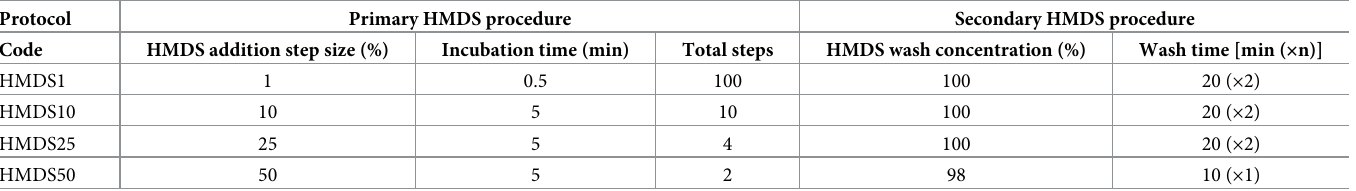
Table 1. The hexamethyldisilazane (HMDS) drying protocols tested. The procedures were all carried out at room temperature (~23˚C), and completed at the end of the secondary procedures by HMDS